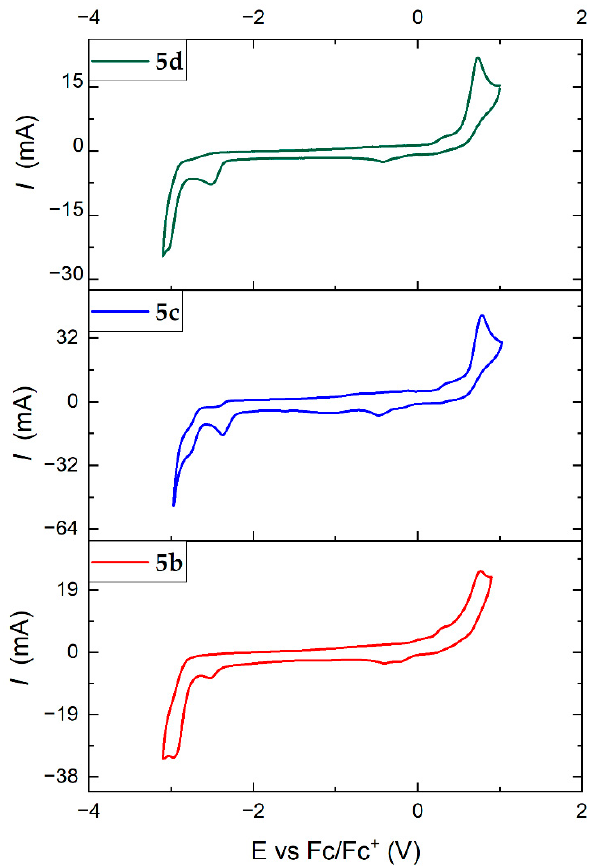
Figure 7. Cyclic voltammetry of Cu(I) complexes 5b ( bottom ), 5c ( centre ), 5d ( top ) in N , N -dimethylformamide (0.1 M TBAPF 6 ) at a scan rate of 100 mV/s.